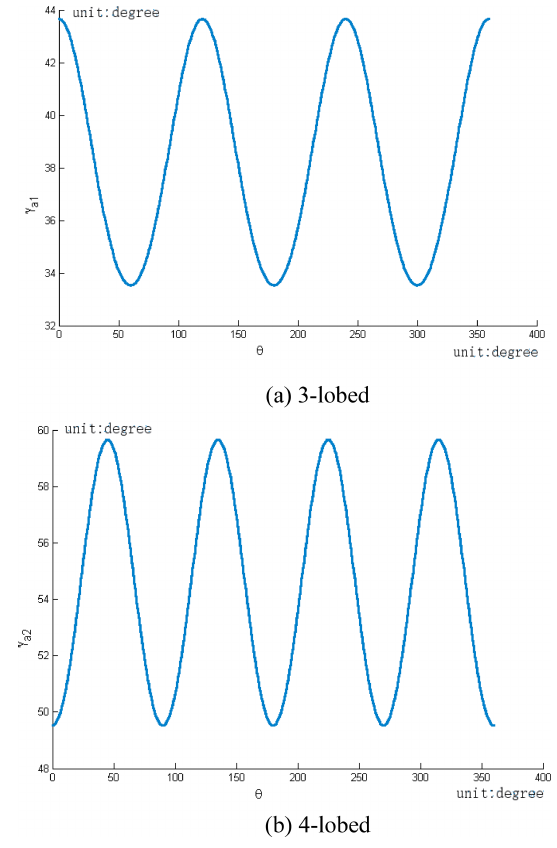
Figure 3. The relationship between the polar angle and the